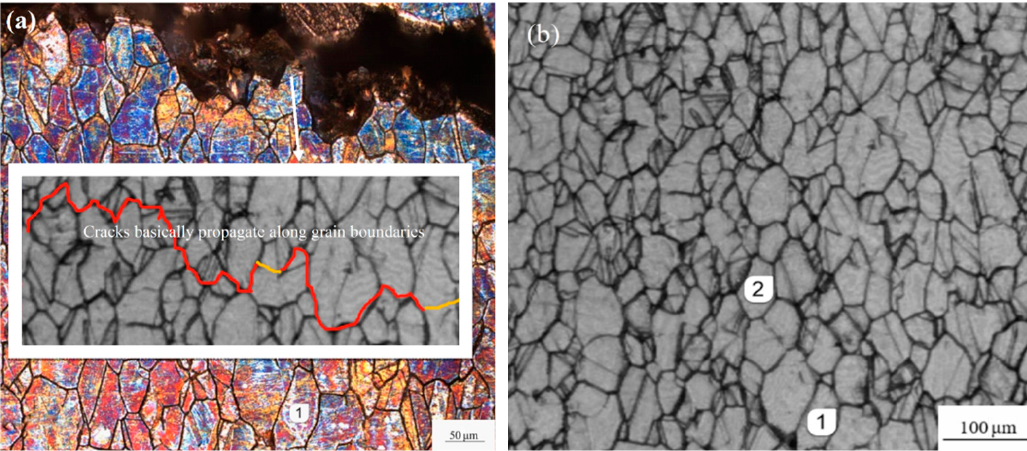
Figure 12. Side view of fracture and corresponding replica film (etched TC specimen): ( a ) the fracture side view of the etched surface specimen; ( b ) the photograph of the replica film before testing.